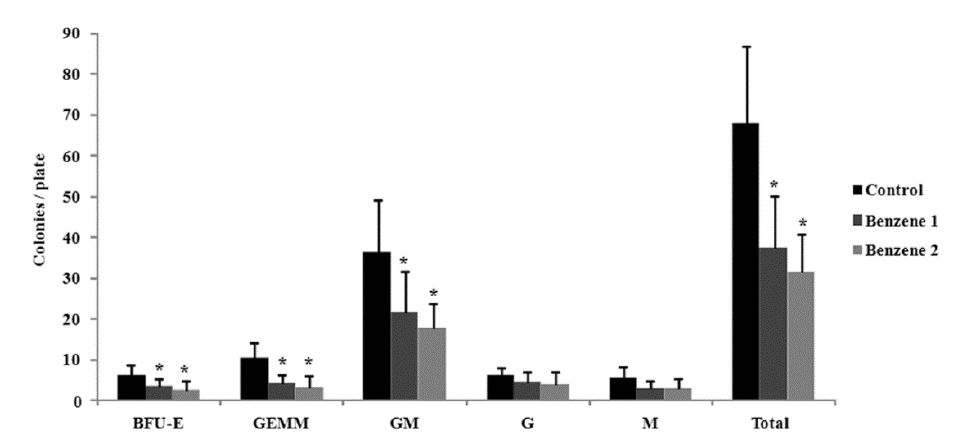
( B ) after 10 months post-benzene exposure. Control: n = 14; Benzene 1: n = 12; Benzene 2: n = 9.* p < 0.05 compared with control.